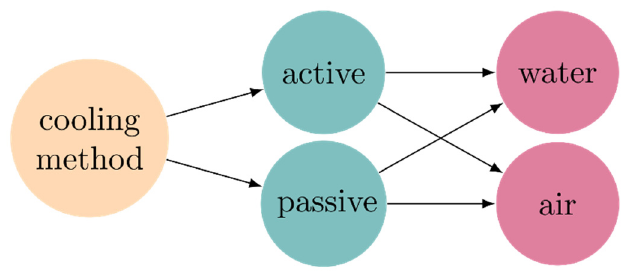
Figure 1. Classification of TEG system cooling.